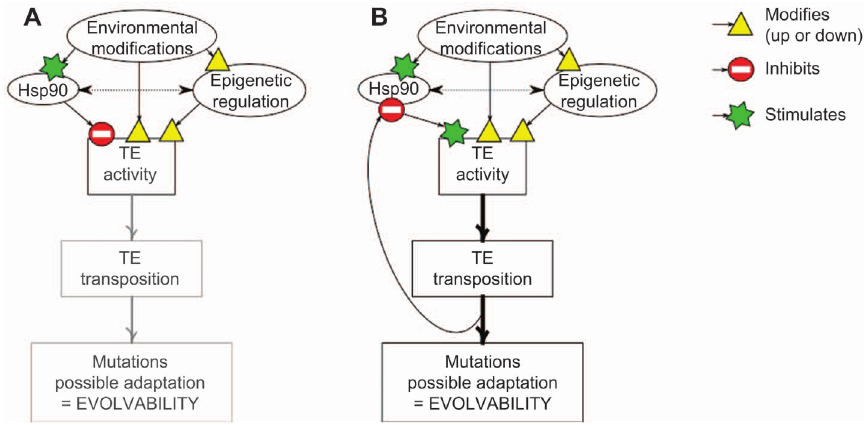
Figure 2 TE transcriptional activity can lead to TE transposition when all the players involved in the mobilization machinery are functional and not